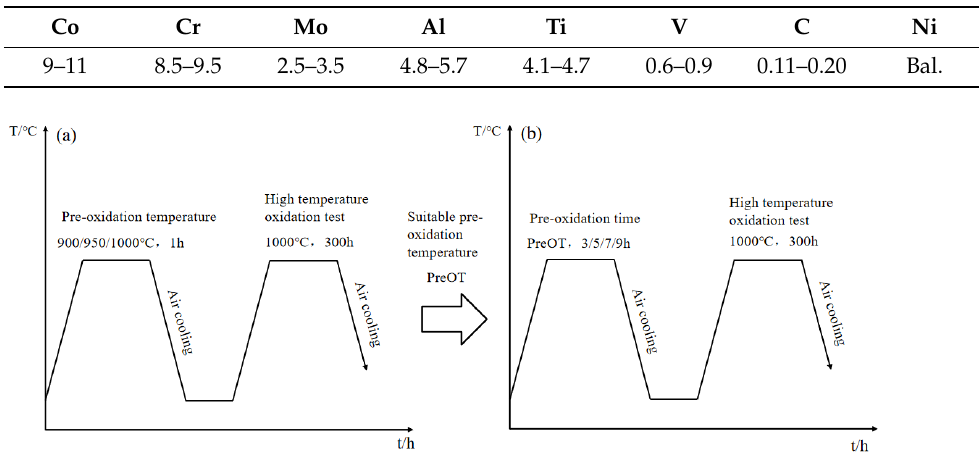
Table 1. DZ417G nickel-based alloy composition (wt.%).